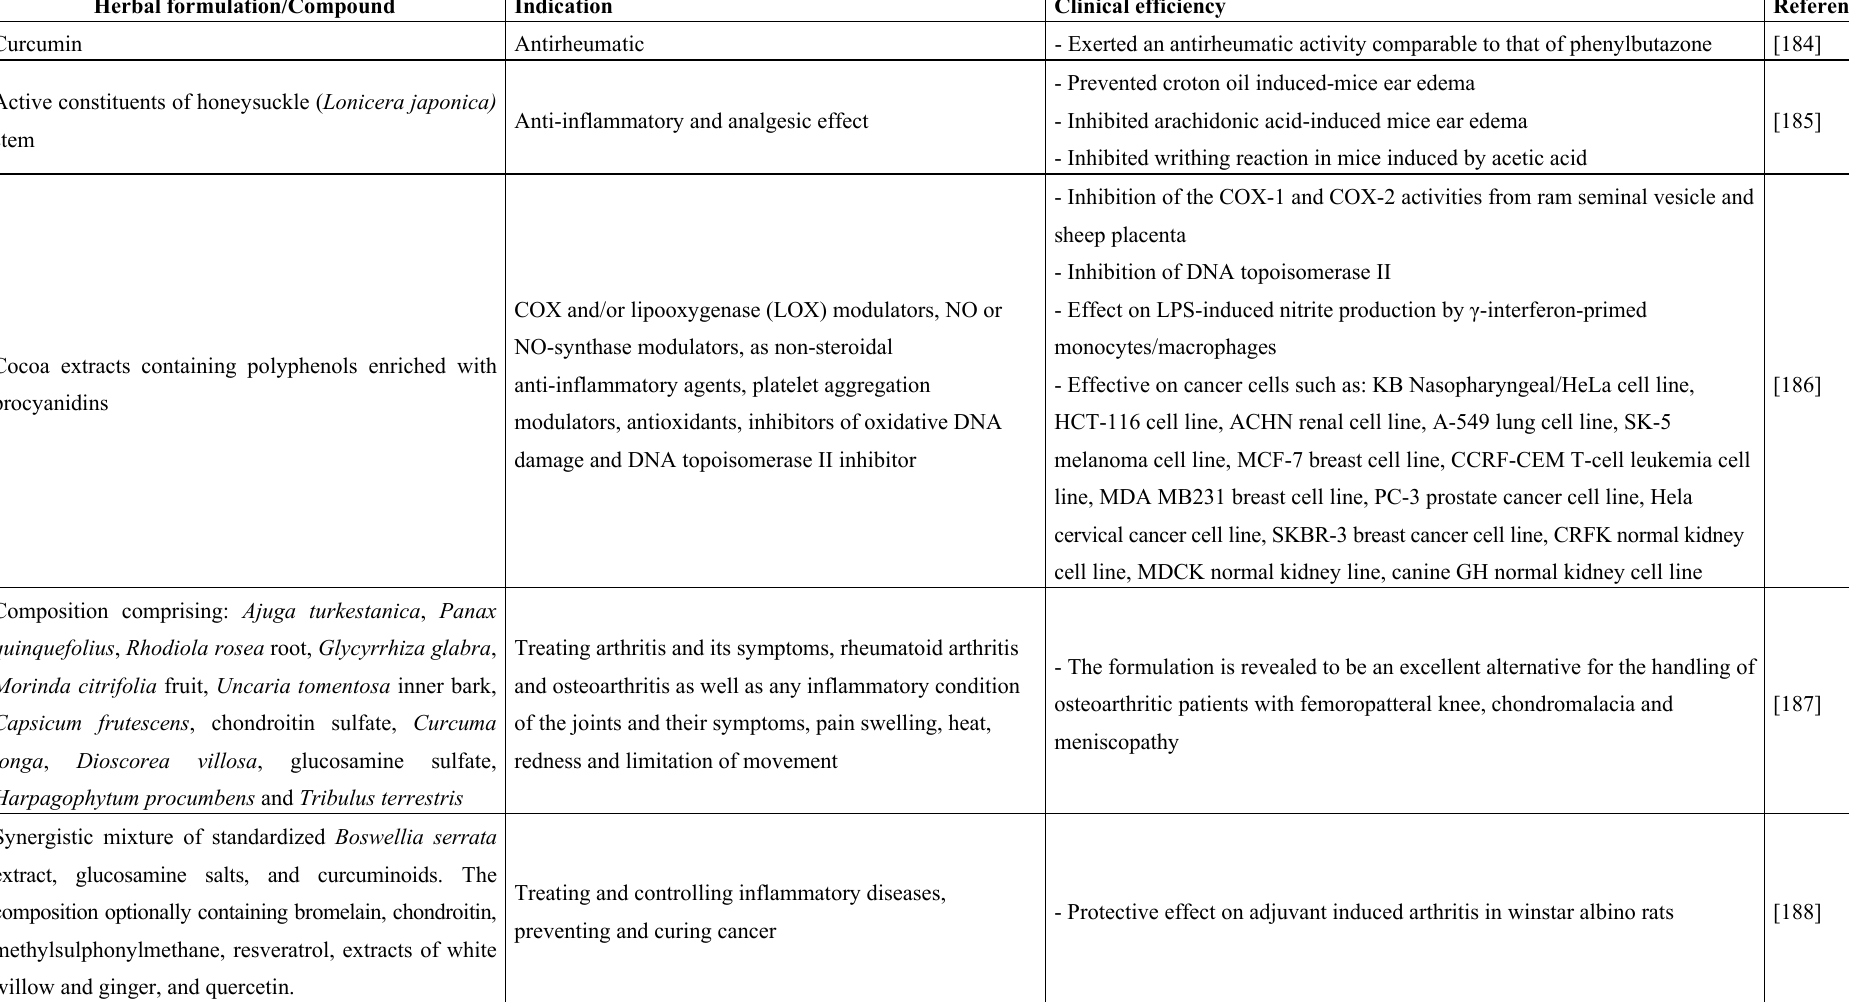
Table 2. Phytochemicals with anti-inflammatory effects and their clinical